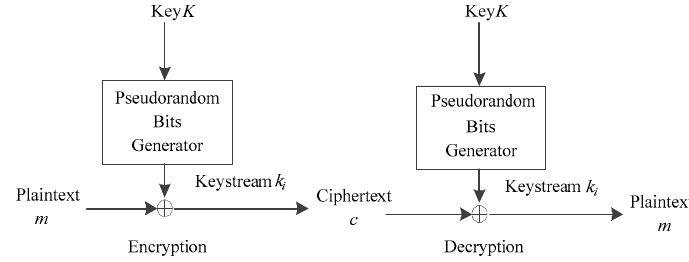
Figure 1. Block diagram of stream cipher.